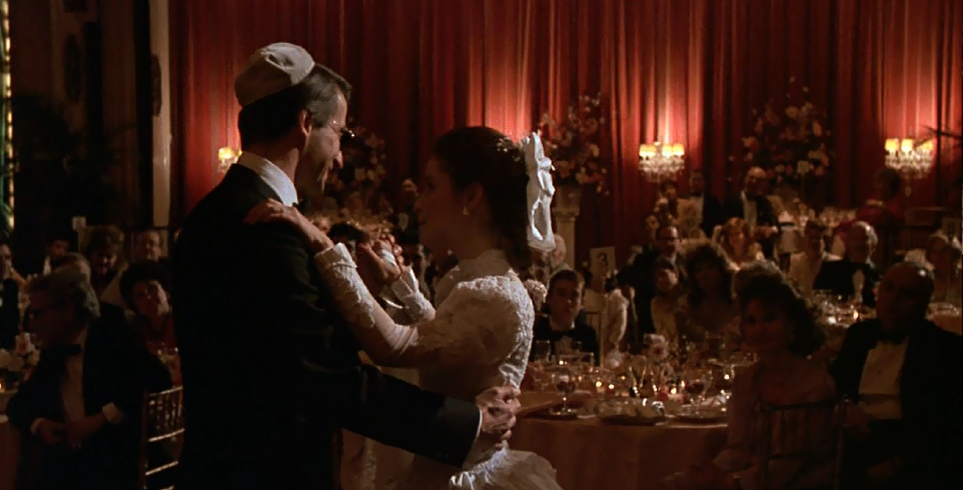
Figure 5: Ben (Sam Waterston) with his daughter (Grace